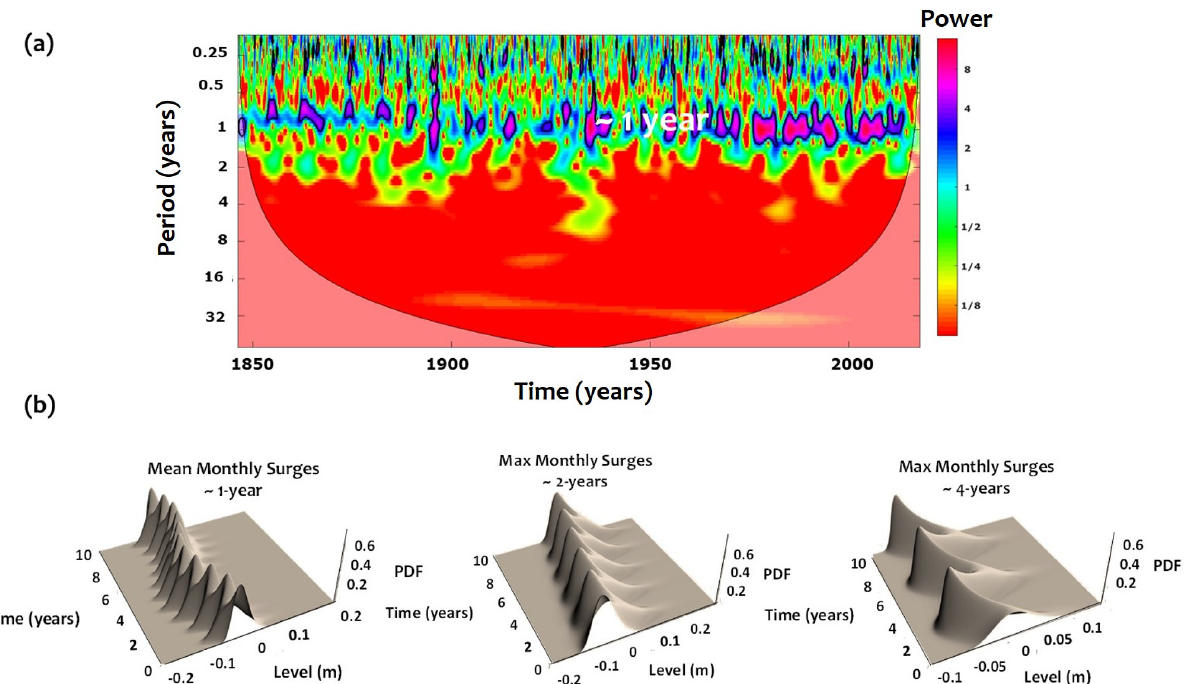
Figure 3. Multiscale variability of the monthly mean and maximum surges in Brest. (a) CWT of monthly mean surges. (b) Interannual variability of monthly and extreme